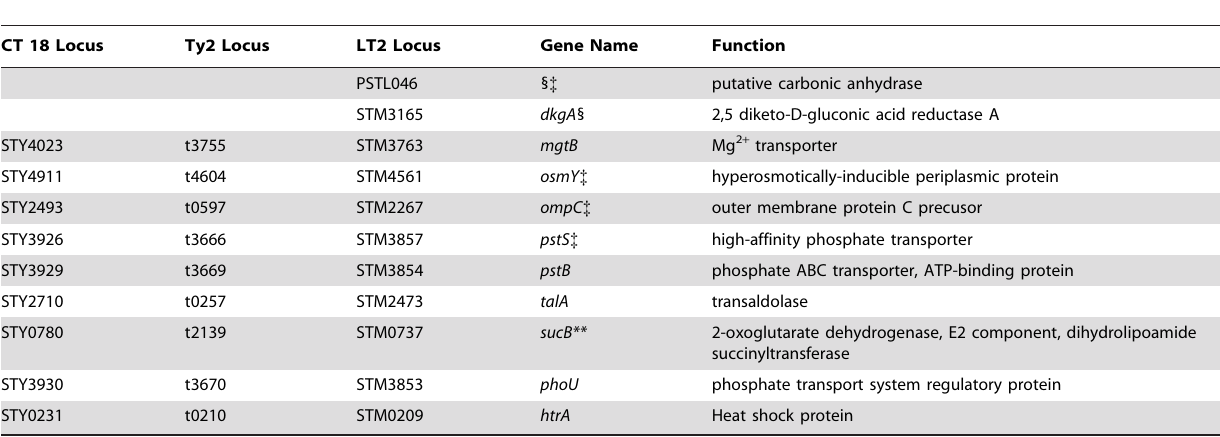
Table 2. PhoP-dependent proteins identified in our proteomic analysis in S. Typhimurium and not in S. Typhi*.